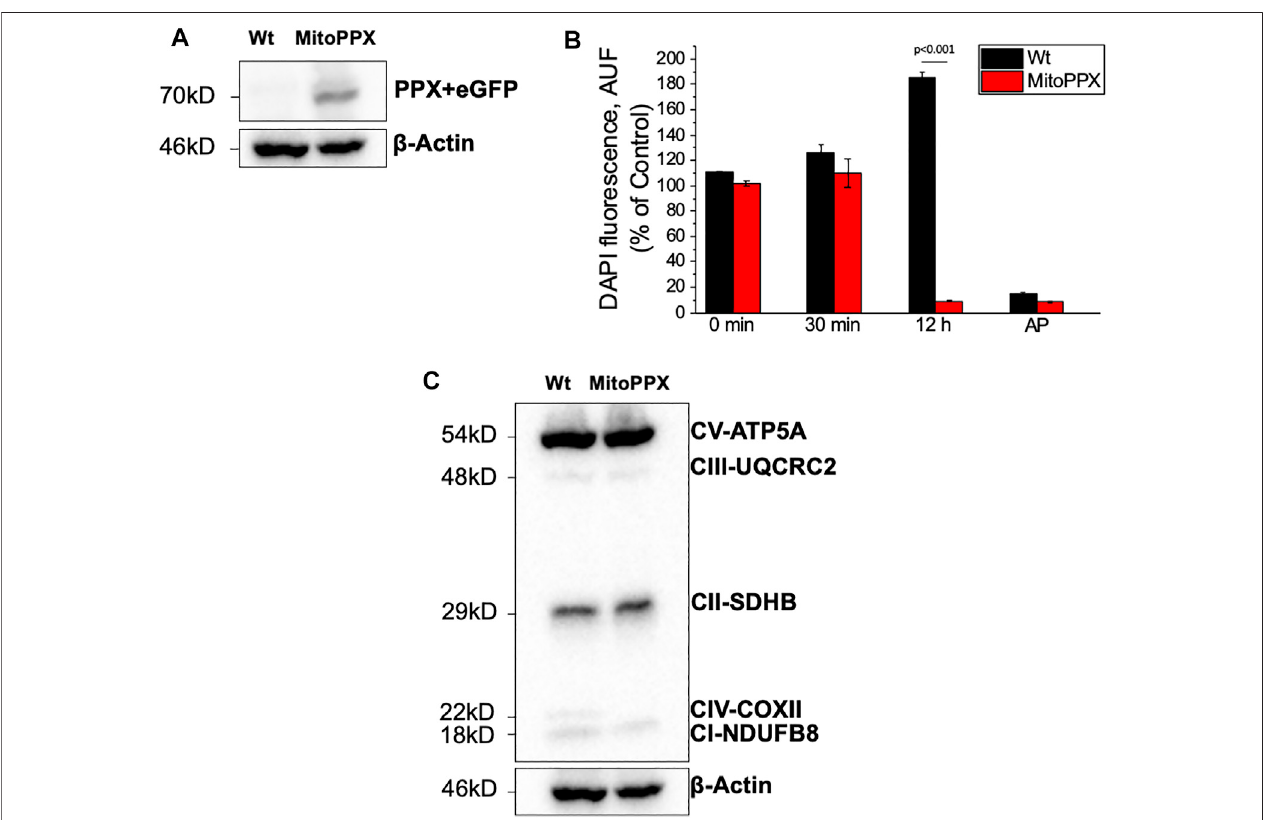
FIGURE 1 | SH-SY5Y neuroblastoma cells overexpressing exopolyphosphatase (PPX) enzyme. (A) Western Blotting con fi rming the expression of PPX (70 kDa together with eGFP protein) in the MitoPPX cells. PPX antibody was used to conduct this experiment. However, the molecular weight shown is the combined molecular weight of PPX and GFP, as the GFP protein is expressed jointly with PPX. (B) Enzymatic assay demonstrating the activity of the PPX enzyme in our MitoPPX SH-SY5Y samples. After 12 h of treatment with exogenous polyP, the levels of the polymer were decreased in MitoPPX cells, compared to Wt ( p < .001). These decreased levels were comparable tothe levels seen in thepositivecontrol, which wasconducted withalkalinephosphatase(AP), an enzyme known todegradepolyP (Lorenz and Schroder, 2001). Results are expressed as mean ± SEM of three experiments. t -test was used to seek for statistical analysis between groups. (C) Western Blotting that shows the expression of different subunits of the ETC complexes in SH-SY5Y Wt and MitoPPX samples that were shipped for metabolomics and proteomics assays ( n = 1).